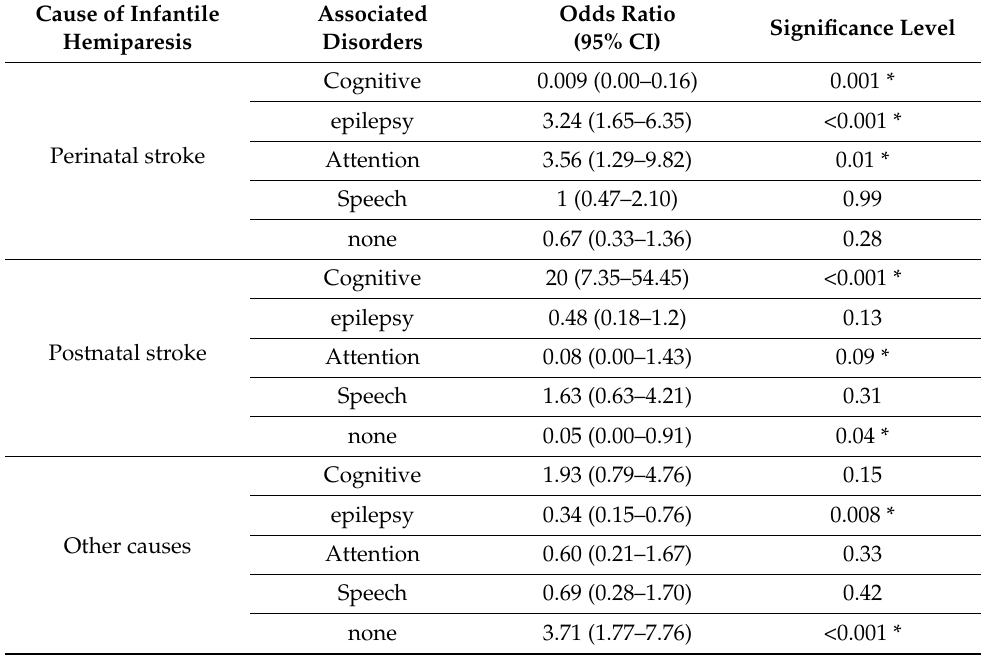
Table 3. Association between the cause of infantile hemiparesis and associated disorders.